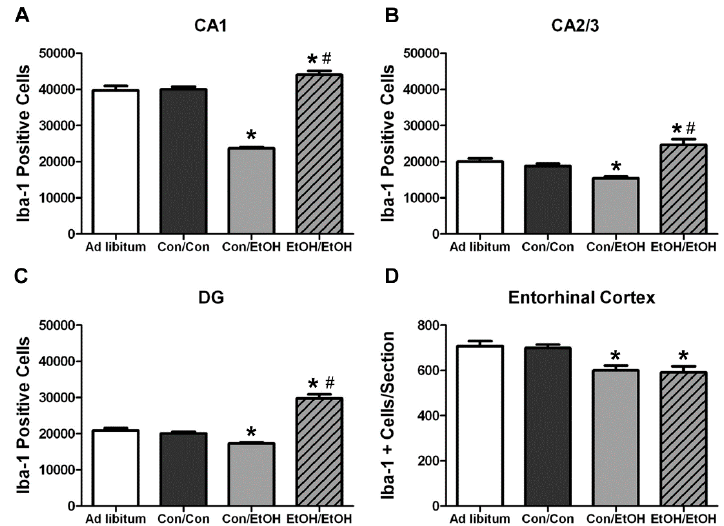
Figure 5. Microglial Cell Counts Differentially Altered by Ethanol Experience. Stereological estimates indicate an increase in the number of microglia in the EtOH/EtOH group in the ( A ) cornu amonis 1 (CA1), ( B ) cornu amonis 2/3 (CA2/3), and ( C ) dentate gyrus (DG) compared with all other groups. However, the number of microglia in the Con/EtOH group was decreased throughout the hippocampus. In the ( D ) entorhinal cortex, microglia were decreased in both the Con/EtOH and EtOH/EtOH groups compared to both the ad libitum and Con/Con groups. * p < 0.05 compared to ad libitum and Con/Con group; # p < 0.05 versus Con/EtOH.